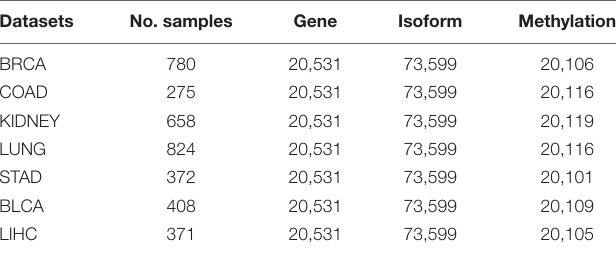
TABLE 1 | Description of seven